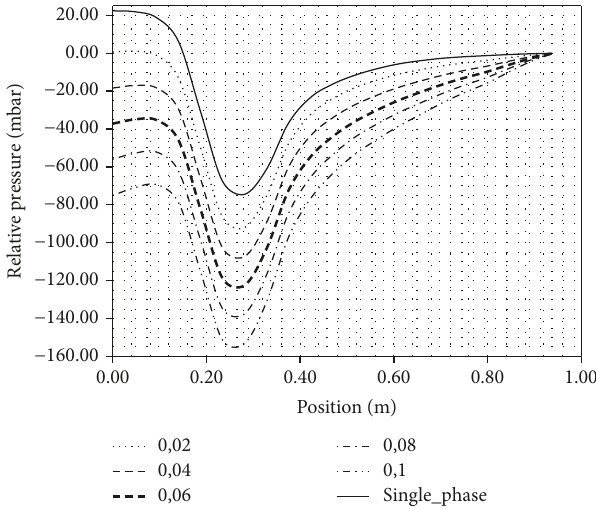
Figure 17: Pressure distribution at minimum mass flow rate for different Ar volume fractions.